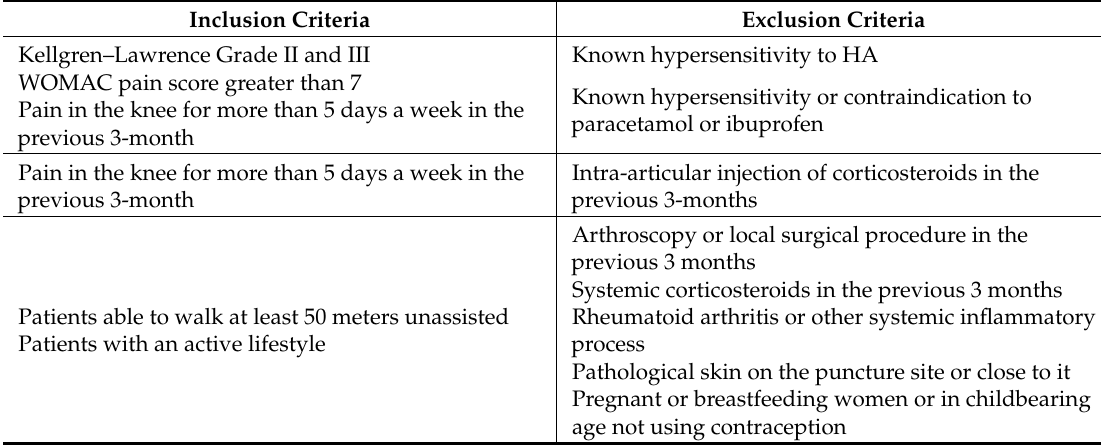
Table 6. Inclusion and exclusion